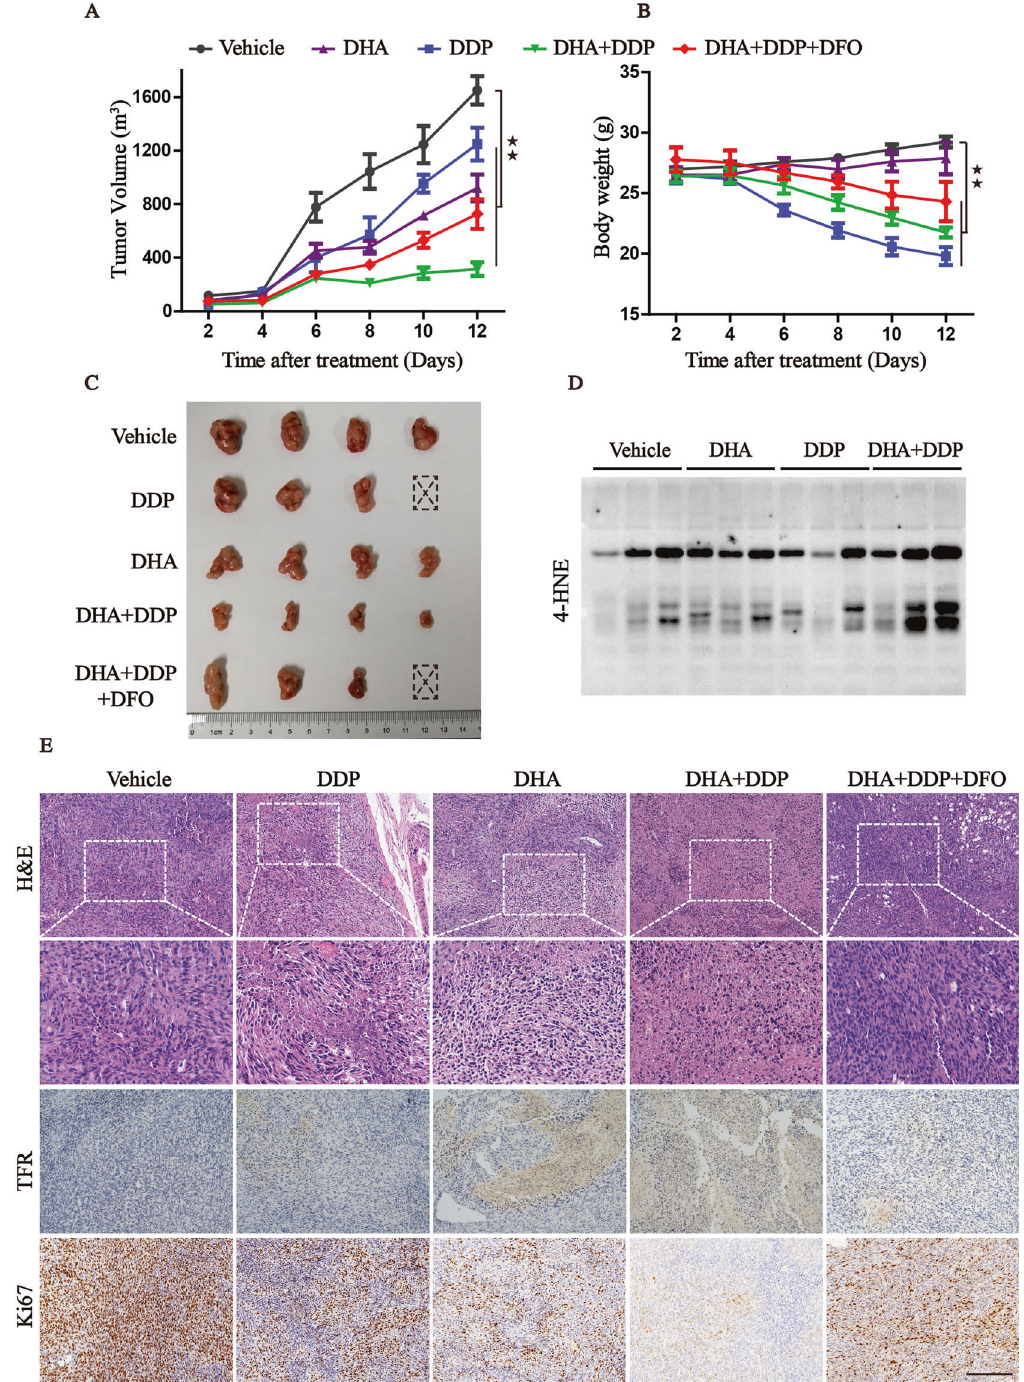
Fig. 8 The combination of DHA and DDP inhibits the growth of xenograft in vivo. A , B Xenografts were established in mice and treated with vehicle, DHA, DDP, DHA/DDP, and DHA/DDP plus DFO, respectively. The tumor volume and body weight were measured every 2 days. C The dissected xenografts were photographed at the end of the experiment. D Western blots analysis for 4-HNE on lysates isolated from xenografts in different groups. E H&E staining and IHC analysis for TFR, Ki67 in indicated tumor specimens. Scale bars: 200 μ m (values represented as mean ± SD. ★★ P < 0.01 versus